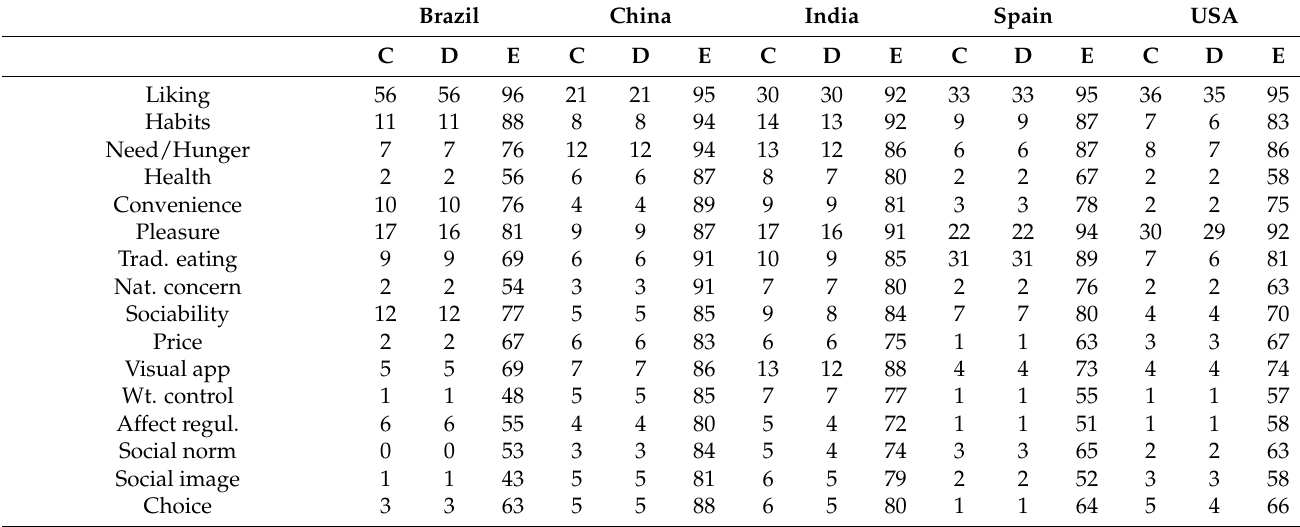
Table A4. Percentage of “apply” responses for CATA, RATA, and RATING for all five countries for the respective desserts.